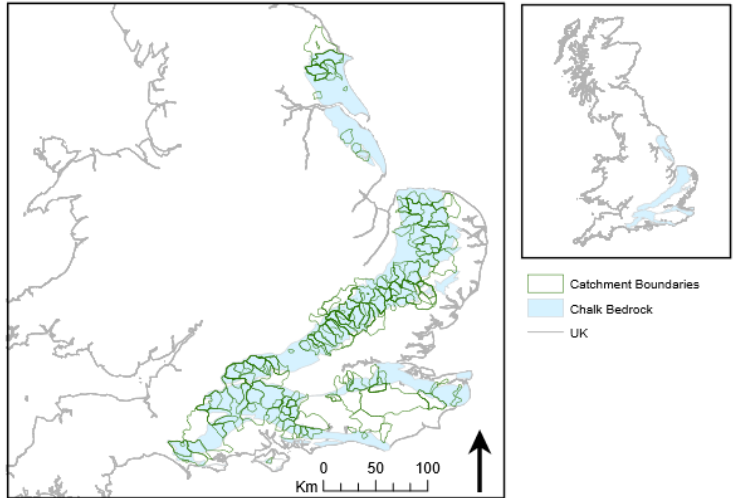
Figure 2. Location of the 198 catchments included in this study underlain by chalk bedrock. Catchment boundaries are from the National River Flow Archive, and the bedrock map is from the British Geological Survey.